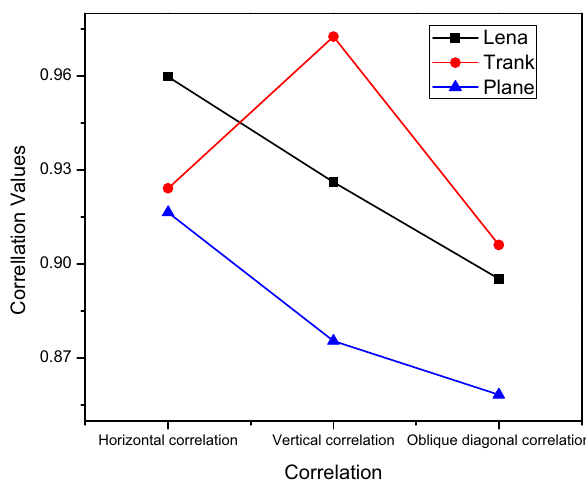
Figure 1: Correlation between adjacent pixels of the image before encryption.